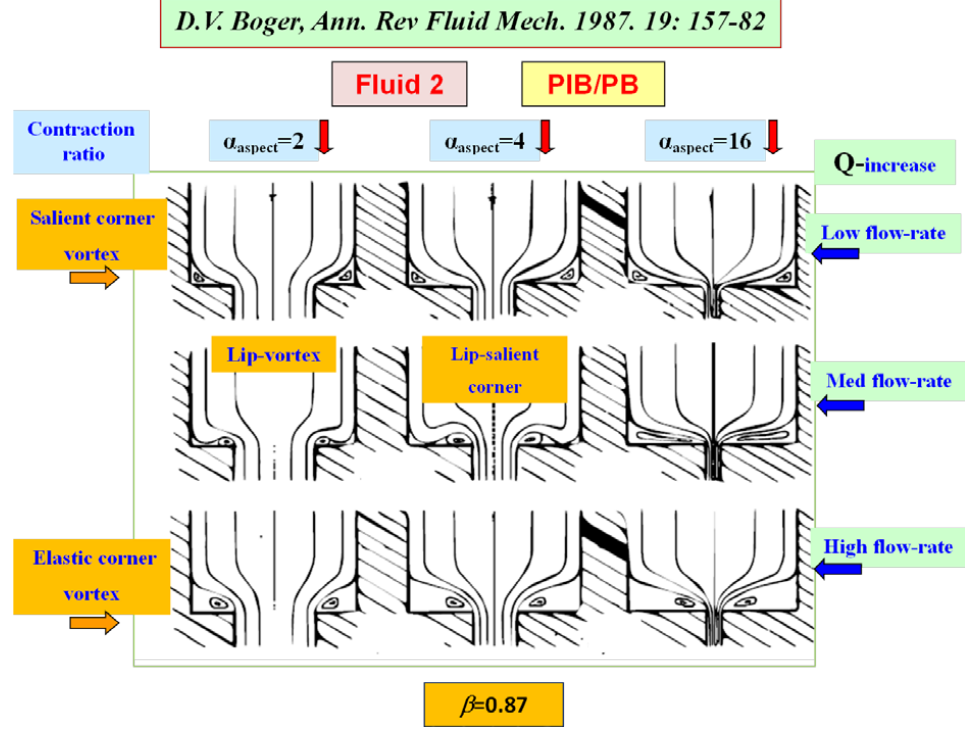
Figure 2. Vortex-activity with increasing flow-rate Q ; Boger Fluid-2 (PIB/PB); β = 0.87, α aspect = {2, 4,